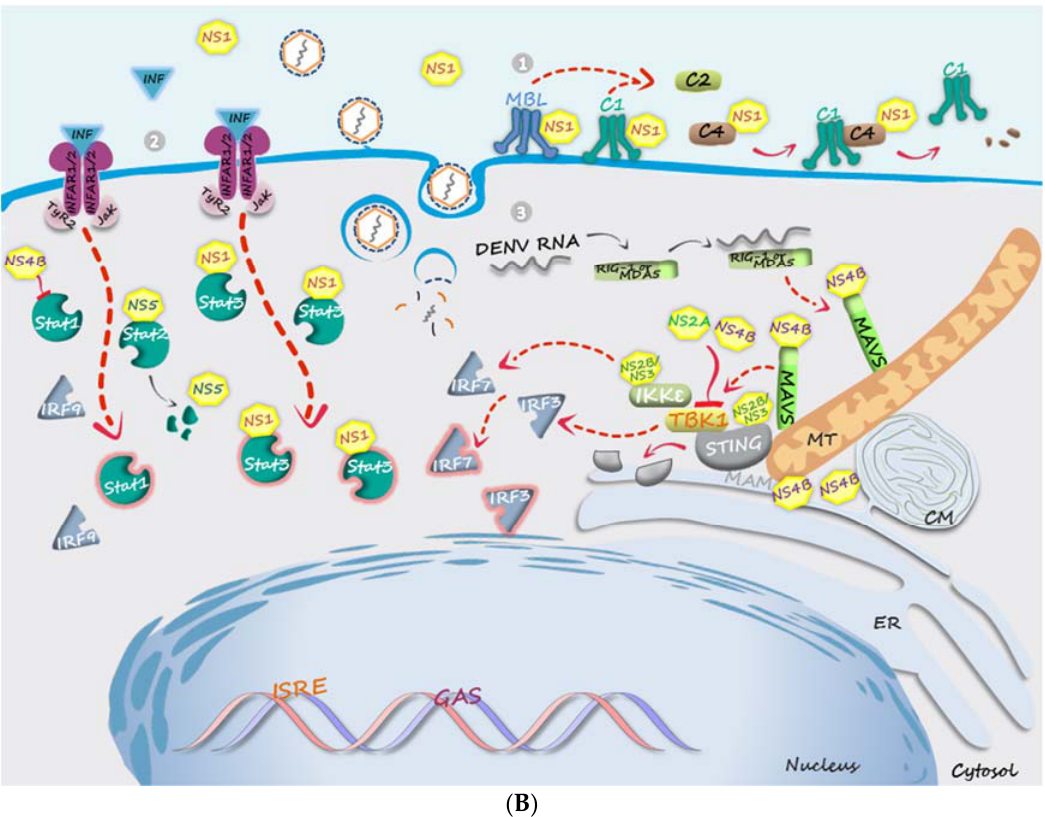
Figure 2. Involvement of DENV NSPs in the evasion of host innate immune response. ( A ) Pathways of immune response affected by DENV NSPs. (1) Activation of the complement system is triggered by different pathways that converge to the cleavage of factor C3 by the protease C3 convertase. This enzyme formed by the association of two other cleavage products: C4b, a fragment of C4, and C2a, a fragment of C2. The cleavage of C4 and C2 may be catalyzed by two different pathways: the classical pathway, triggered by C1 binding to antigen ‐ antibody complexes, or by the lectin pathway, in which a carbohydrate recognition receptor, such as mannose binding lectin (MBL), associates to a serine protease after binding to carbohydrates. One of the products of C3 cleavage, C3b, binds to C3 convertase changing its substrate specificity, so that the enzyme becomes a C5 convertase. The fragment C5b, generated from the cleavage of C5, binds to the infected cell membrane, initiating the assembly of a complex formed by C6, C7, C8, and C9, which promotes cell lysis. (2) Viral dsRNAs